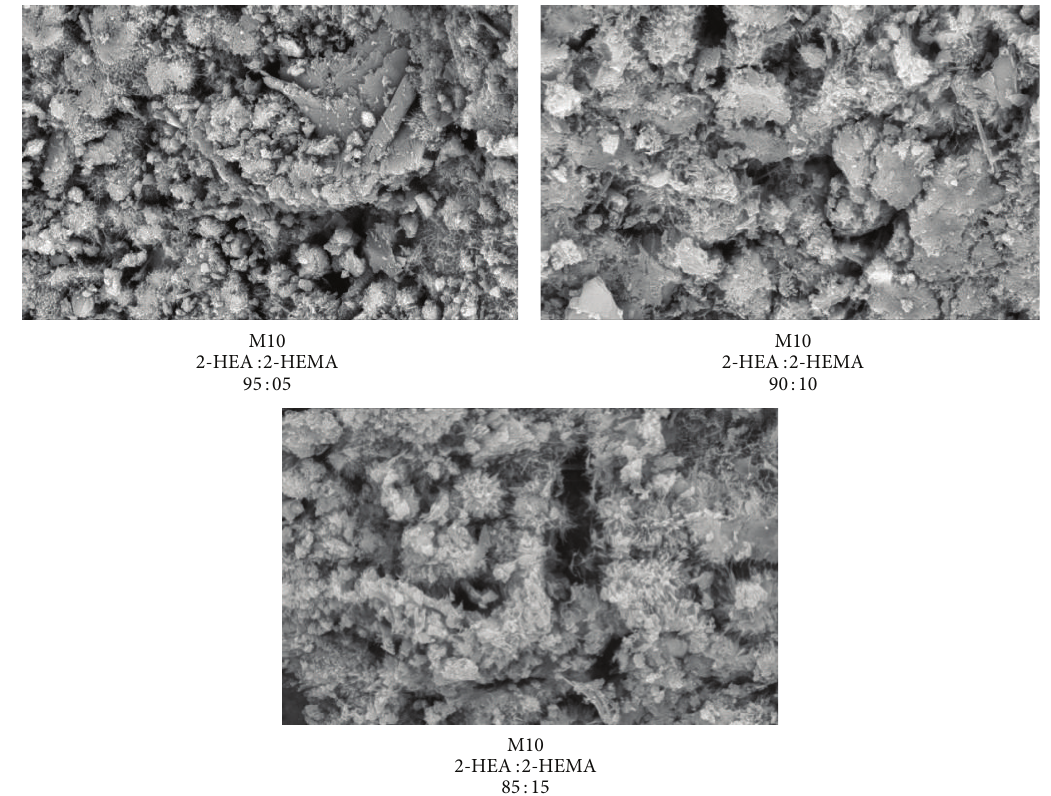
Figure 12: Scanning electron micrographs of mortar containing 10% FA in presence of